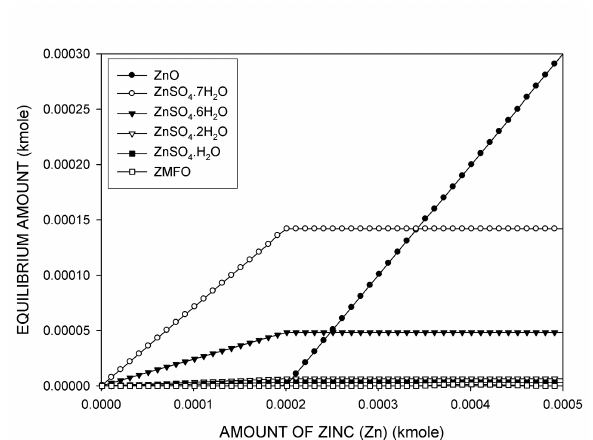
Figure 10(b). Effect of the amount of iron the equilibrium amounts of the zinc-containing species at 298 K for the Zn-Fe-Mn-O-C-H-S system.